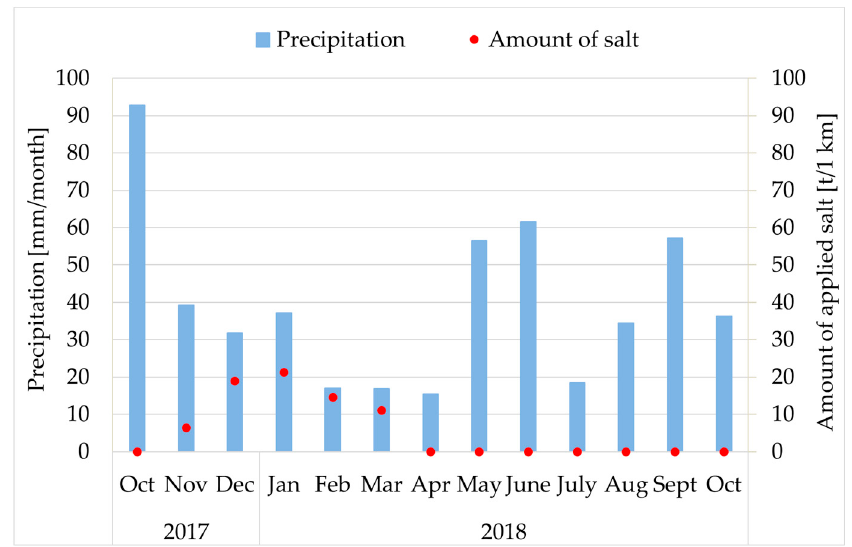
Figure 4. Amount of precipitation and applied de-icing salt during the sampling period for both sites.